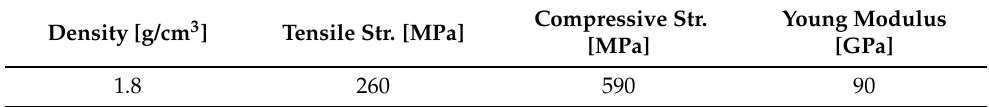
Table A5. CMC material